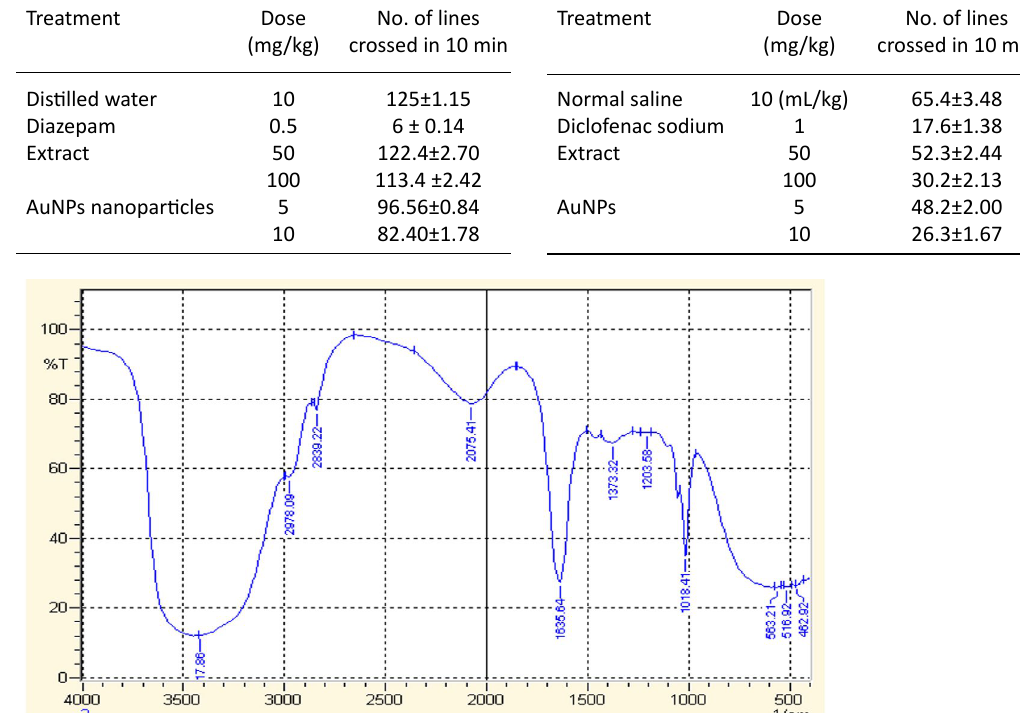
Fig. 3. FTIR spectrum of AuNPs synthesized by mixing extract stock solution and salt solution (1:2,